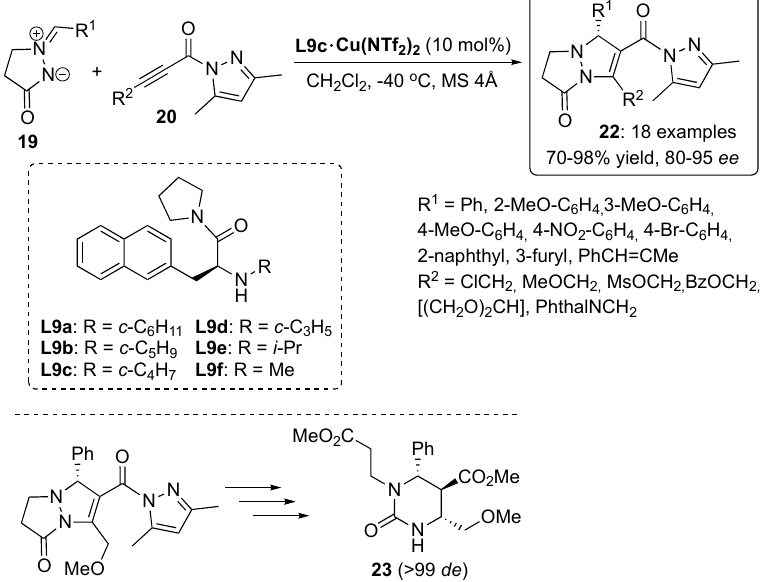
Scheme 8. Asymmetric π –cation catalyst-induced cycloaddition of N , N -cyclic azomethine